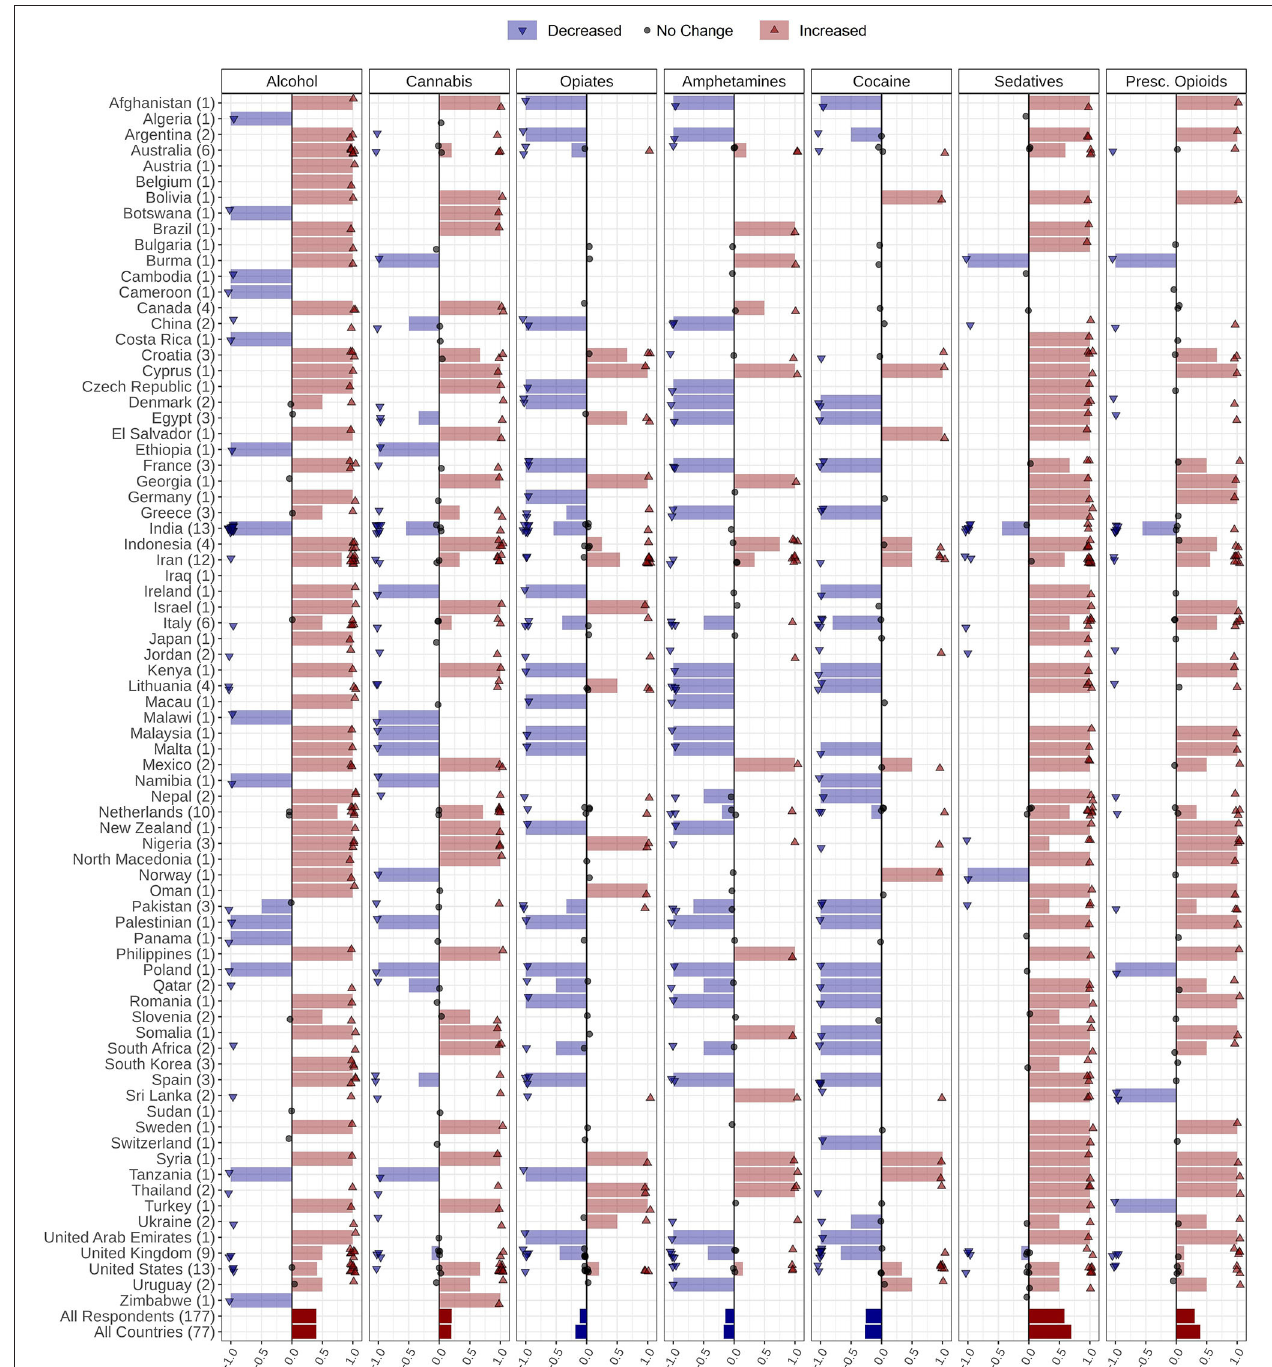
FIGURE 2 | Changes in alcohol and drug use during the COVID-19 pandemic reported by 177 respondents from 77 countries globally. Respondents were asked to report changes in alcohol, amphetamines, cannabis, cocaine, opiates, prescribed opioids, and sedative-hypnotics use with the following options: Increased, Decreased, Not changed, I do not know, and Number of users is very low/none. Countries’ names are sorted in alphabetical order, and the number of respondents from each country is in parentheses following the country name. Each response is indicated as a single dot for no change or up and down triangles for increased and decreased answers, respectively, with a minor jitter for better visualization. The reported answers are represented as − 1 for decreased , 1 for increased , and 0 for no change. I do not know and Number of users is very low/none answers are not shown in the figure. The mean of all responses, regardless of their originated countries and without considering those who did not know the answer or reported very low/none number of users, alongside the average answers of all countries, regardless of the number of respondents in each country, are addressed in the last two rows below the countries’ names (Pres. Opioids: prescription opioids).